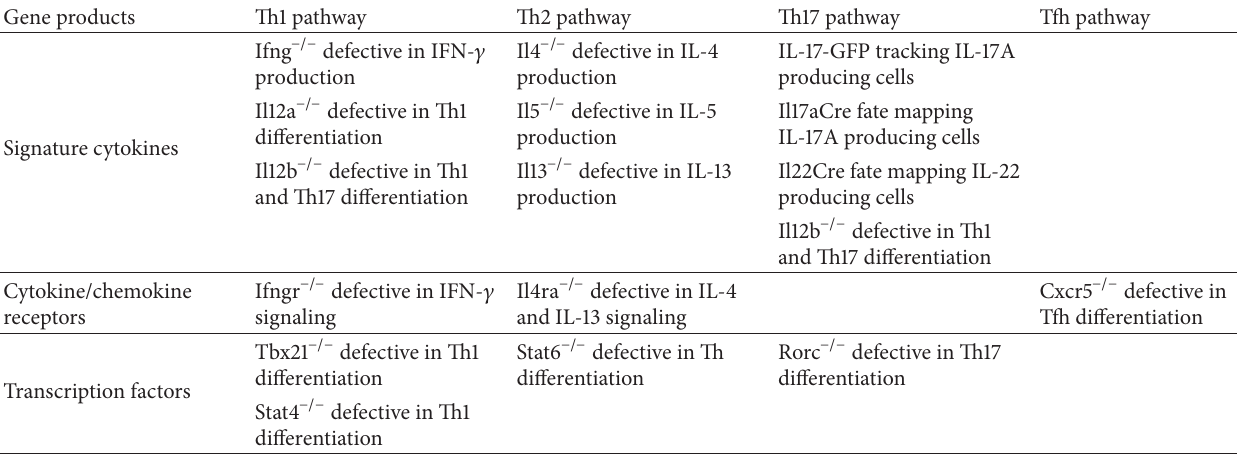
Table 1: Genetic KO mice that are commercially available for studying A. baumannii